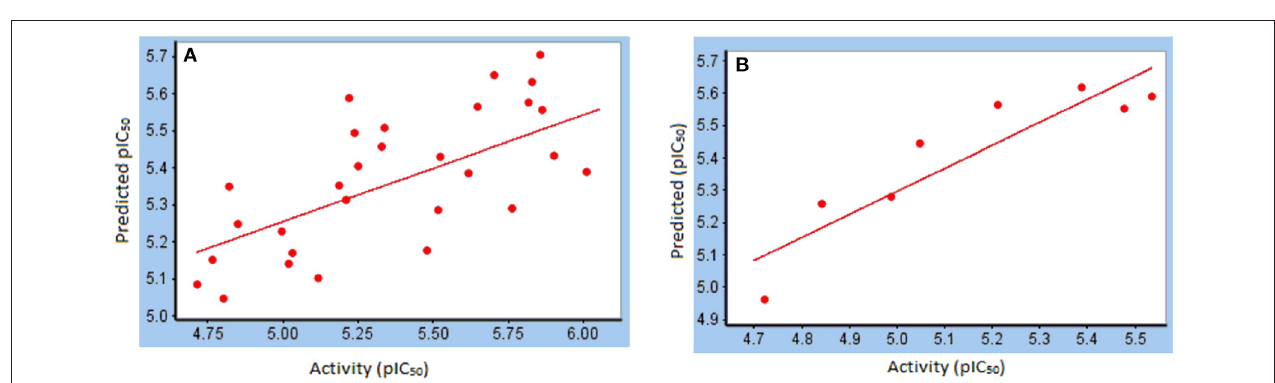
FIGURE 5 | Correlation between experimental pIC 50 and predicted pIC 50 from (A) training set; (B) test set.